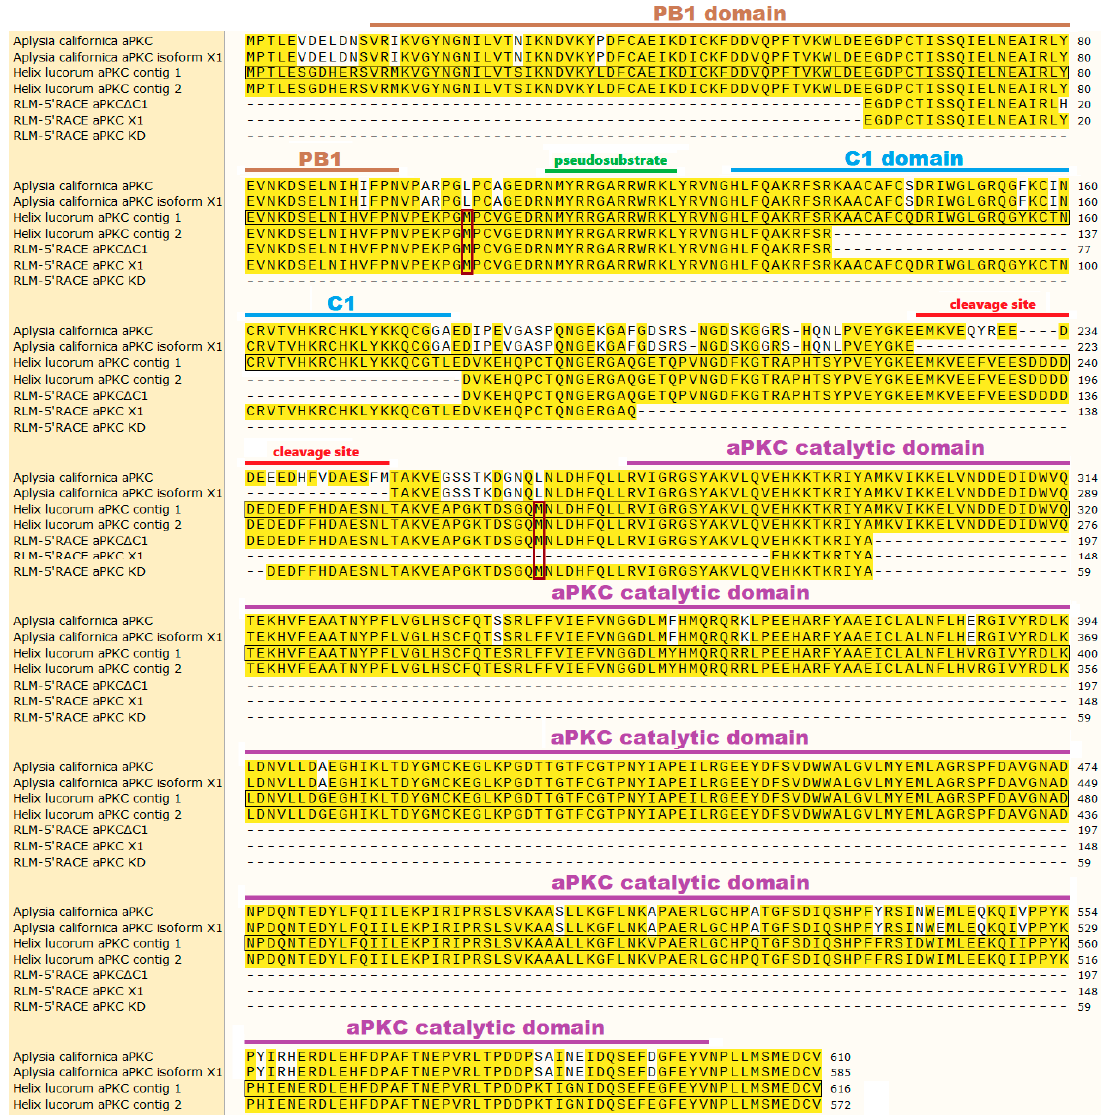
Figure 1. Multiple alignment of translated sequences: two isoforms of Aplysia’s aPKC ( Aplysia californica aPKC and Aplysia californica aPKC isoform X1), two snail mRNA contigs (assembled from snail full-transcriptome sequencing data) homological to Aplysia’s aPKC mRNA ( Helix lucorum aPKC contigs 1 and 2), and three RLM-5’RACE sequences (RLM-5’RACE aPKC ∆ C1, RLM-5’RACE aPKC X1, and RLM-5’RACE aPKC KD). Yellow coloring represents similarity to the common reference sequence, Helix lucorum aPKC contig 1 (framed). Domains and features are labeled based on similarity with annotated Aplysia’s sequences [36]. Red frames mark two possible translation starts present only in snail sequences.